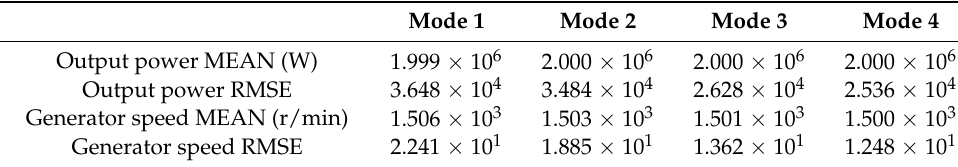
Table 2. The control performance